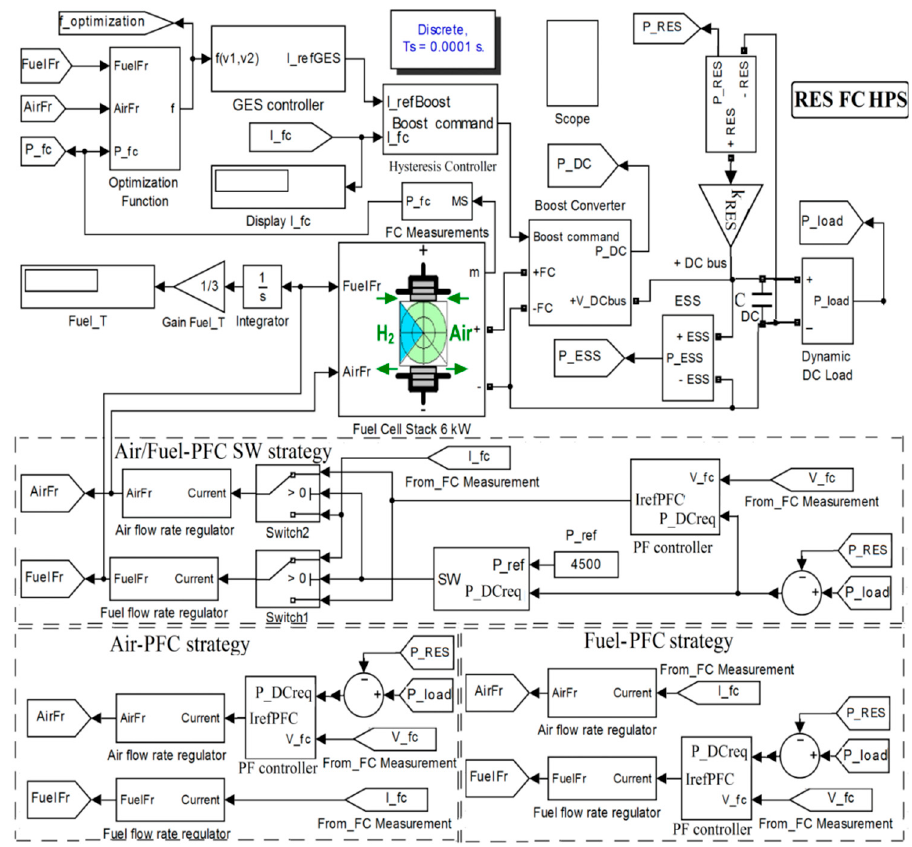
Figure 3. The FC / renewable HPS using power-following control (PFC) strategies air-PFC, fuel-PFC, and air / fuel-PFC [34].